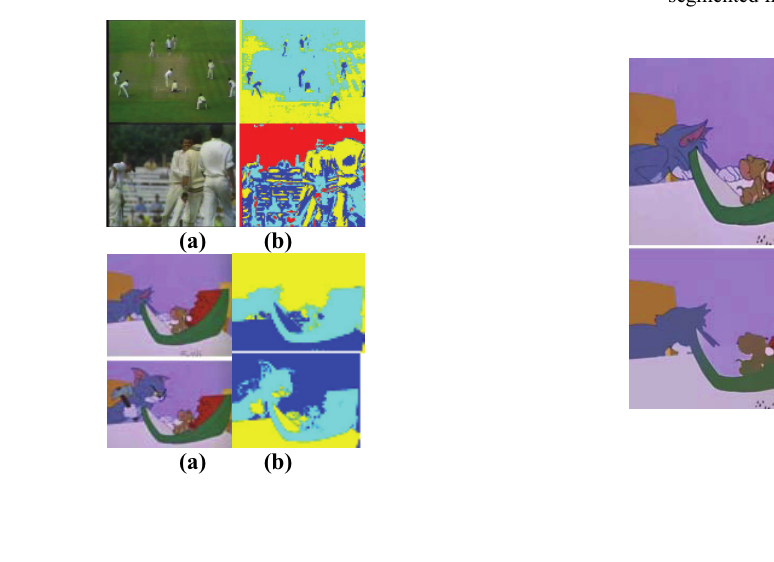
Fig. 5.5. Sample frames and their corresponding color segmented frames of three different